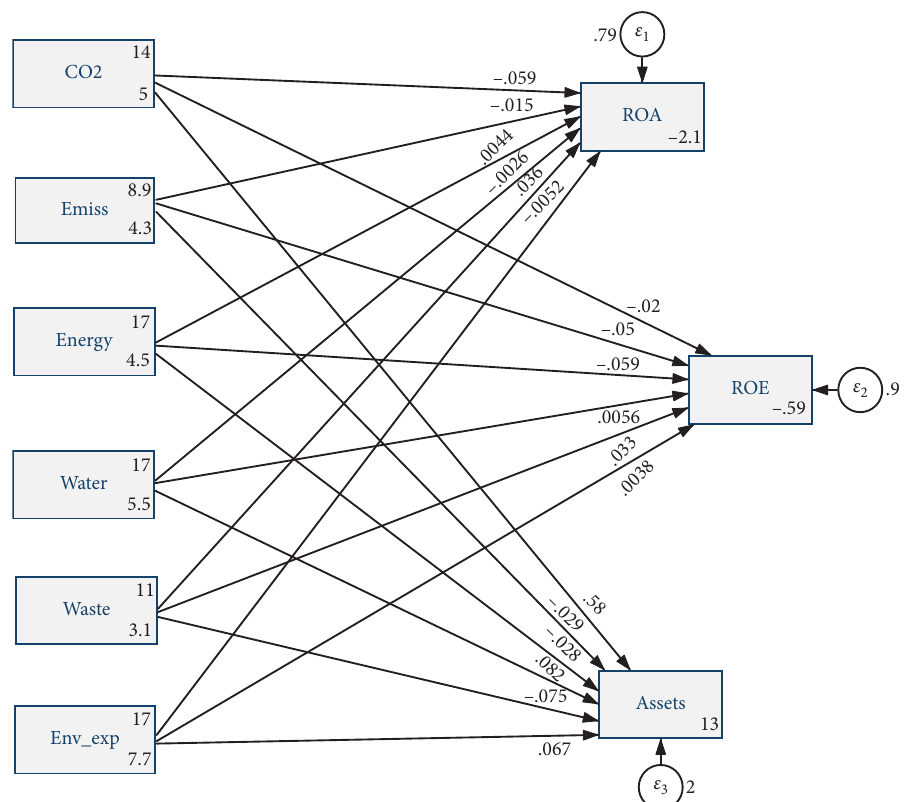
Figure 4: The association between concrete measures and the financial performance (SEM), for oil and gas companies from the EEA, 2009–2018. Source: own contribution in Stata 16.